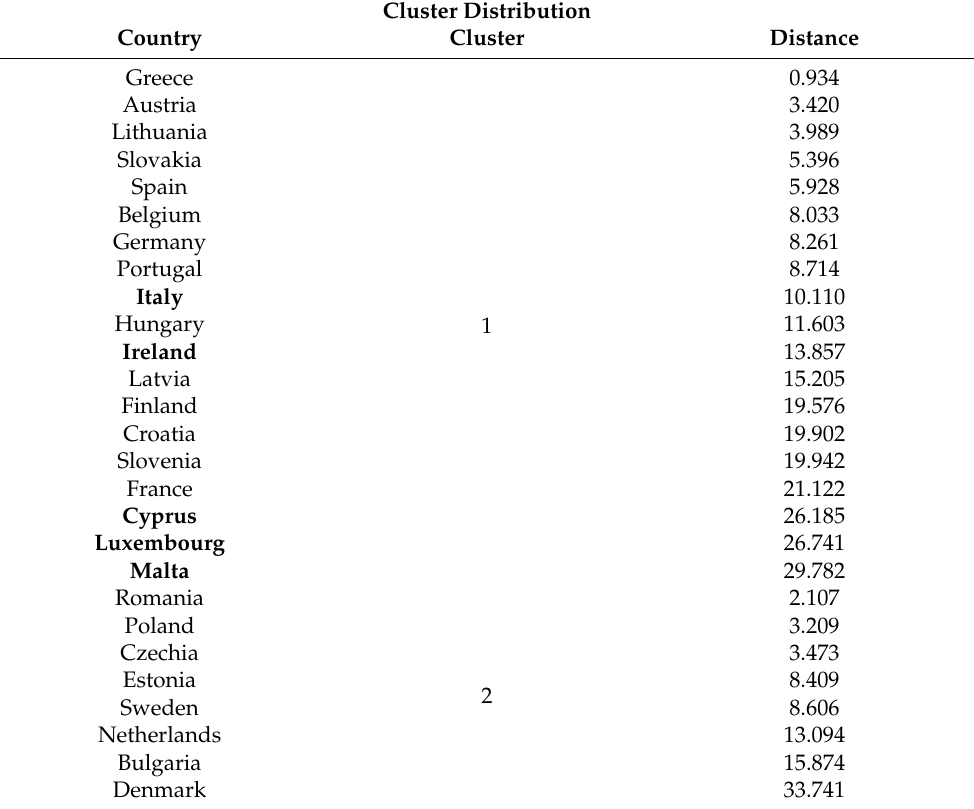
Table 7. Cluster